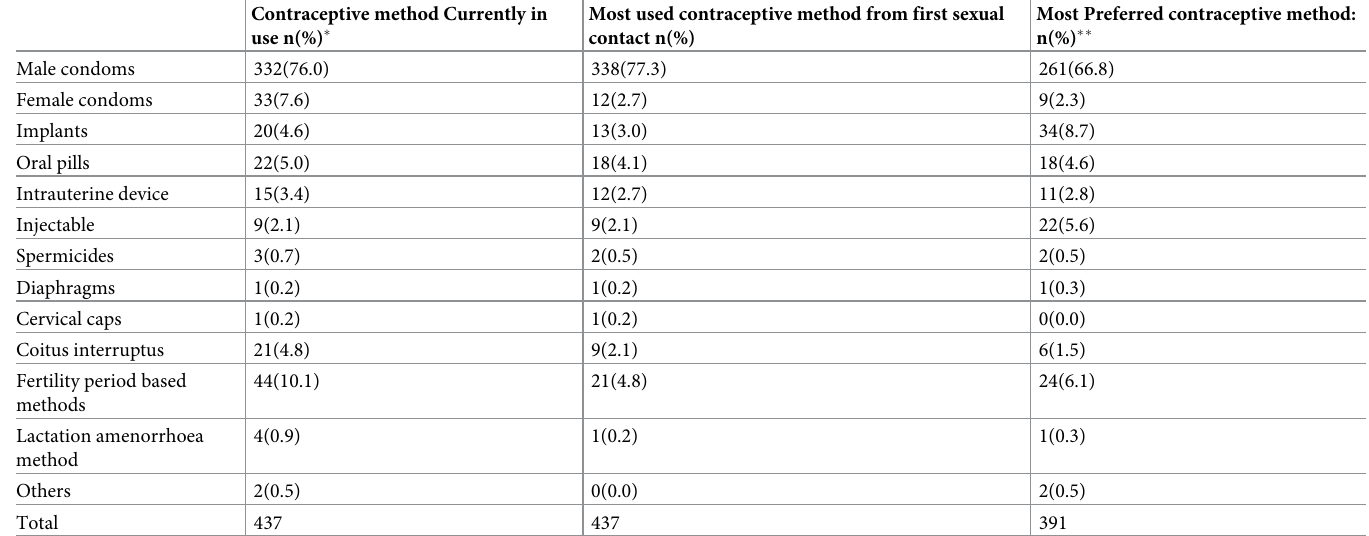
Table 1. Contraceptive methods used and